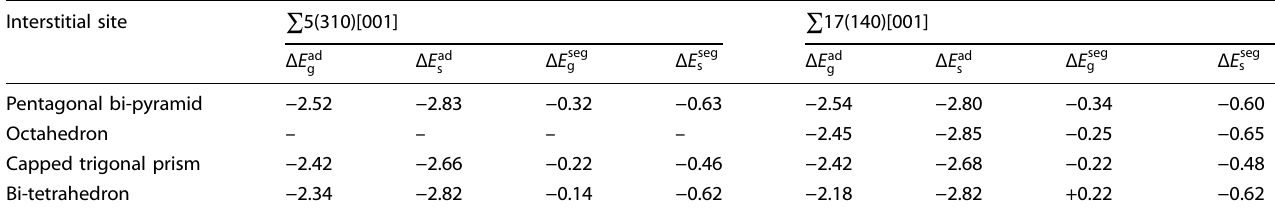
Table 2. H trapping sites and adsorption energies (eV per atom) at GBs and separated surfaces; H segregation energies from the bulk lattice to GBs and separated surfaces, Δ E